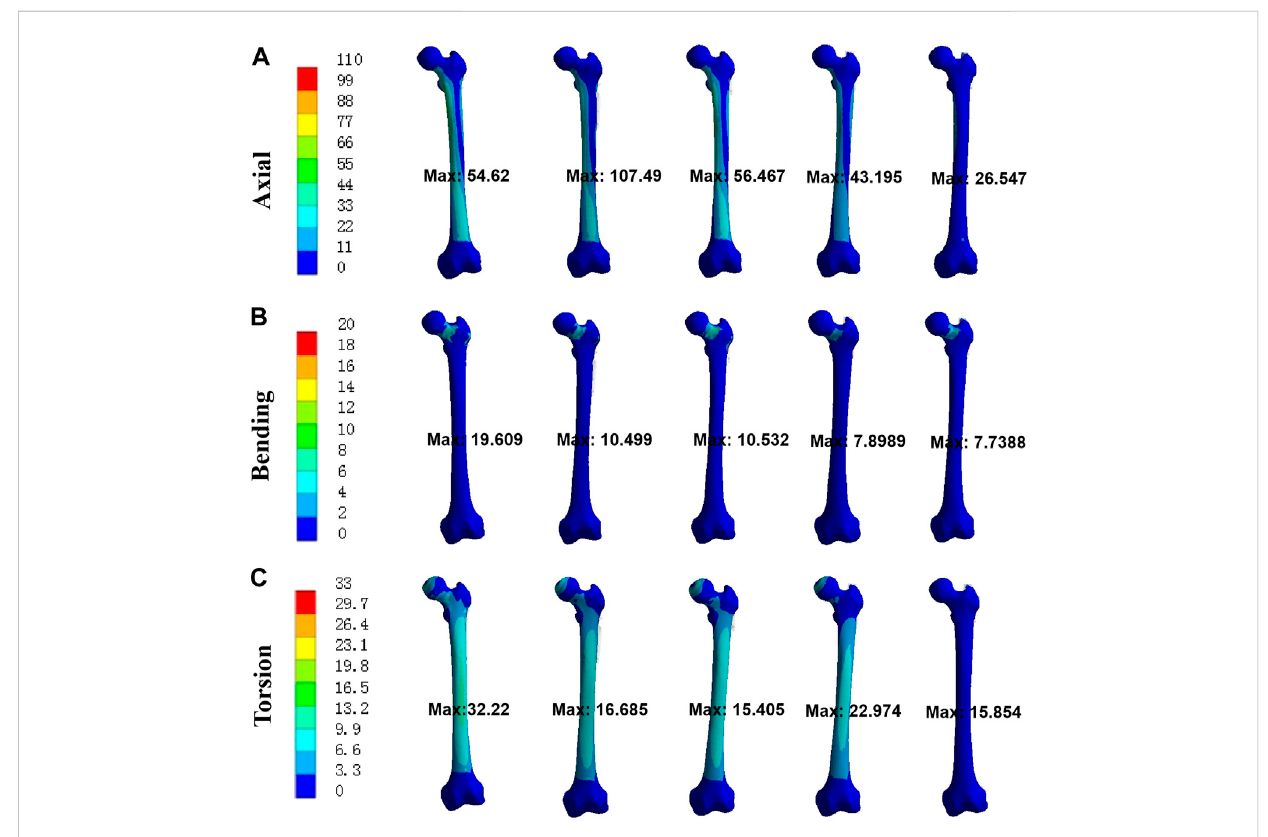
FIGURE 6 Von Mises stress at bones for three different loads. (A) axial; (B) bending; (C)